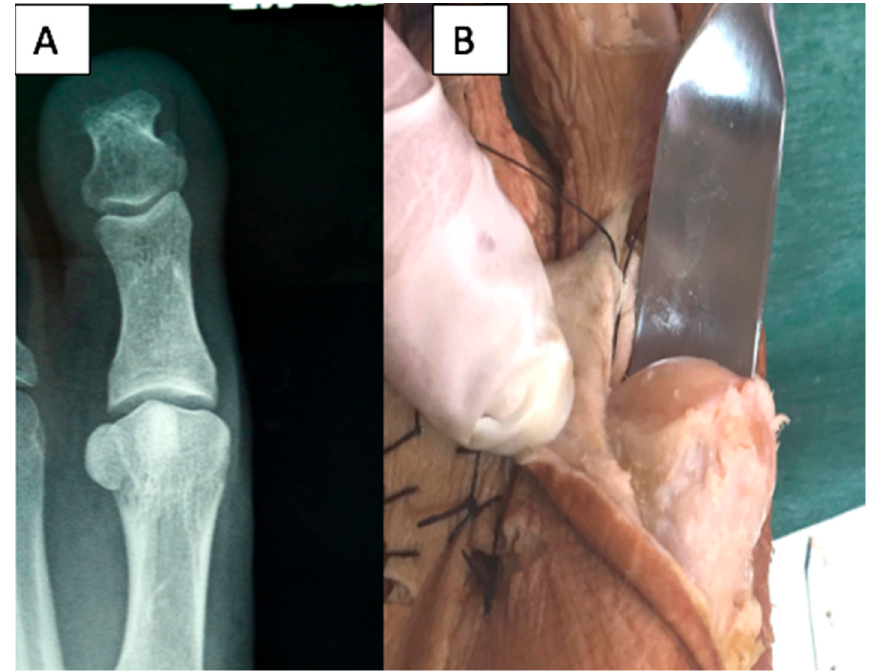
Figure 2. Views of a first metatarsal head showing distortion to appear crest shaped in a radiographic image performed to 30° ( A ) and after dissection revealing a round shape ( B ).